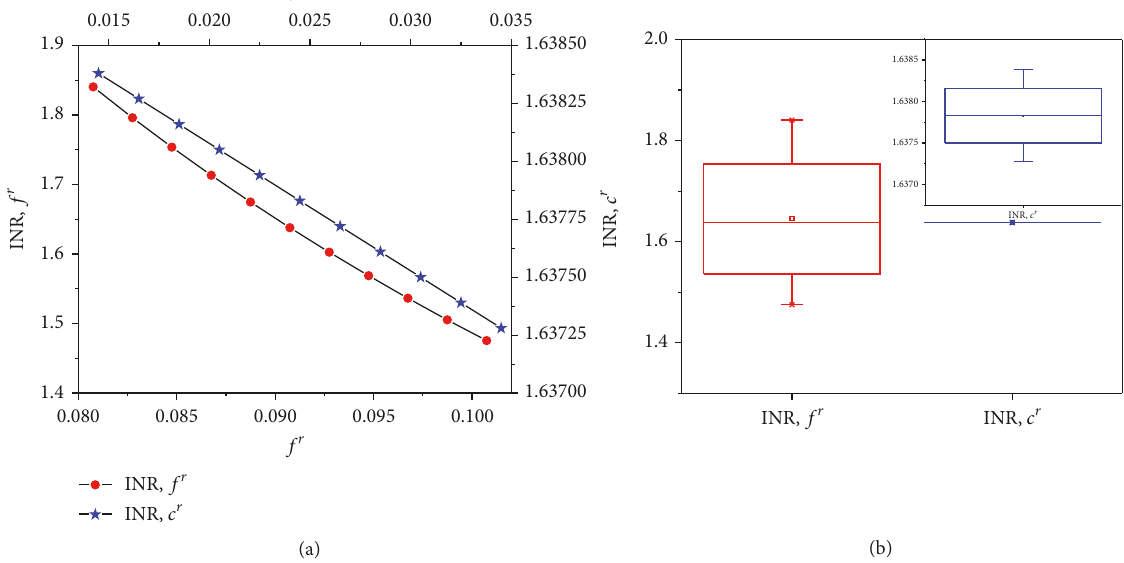
Figure 5: (a) Sensitivity analysis for the deviation of 𝑐 1 ( 𝑐 𝑟 1 ) and of 𝑓 1 ( 𝑓 𝑟 1 ) and (b) box charts for INRs under changes of 𝑐 1 ( 𝑐 𝑟 1 ) and 𝑓 1 ( 𝑓 𝑟 1 ).